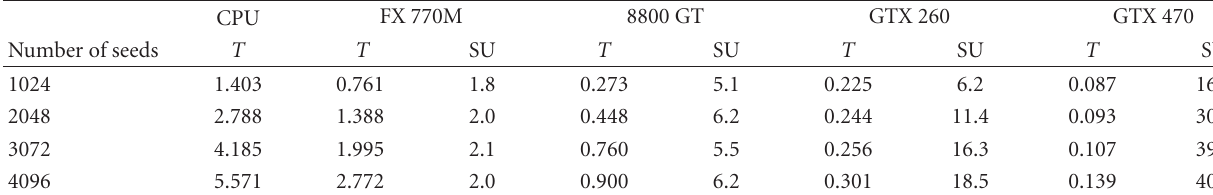
Table 3: Benchmark results for GPU and CPU implementation of the geodesic ray-tracing algorithm. For each configuration, we show the running time (T) in seconds, and the Speed-Up factor (SU) relative to the best CPU timing, see Figure 7. CPU